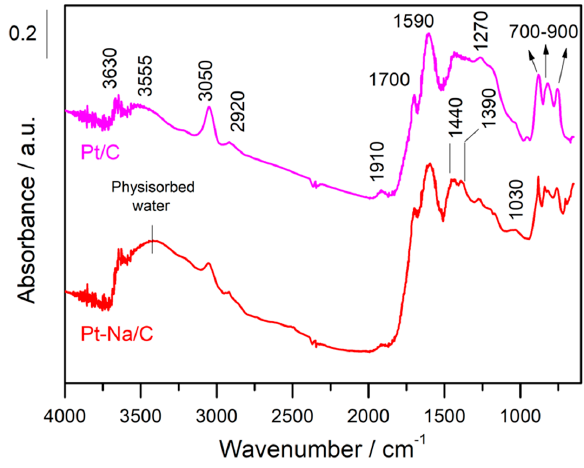
Figure 4. DRIFT spectra of both catalysts recorded at room temperature (RT).